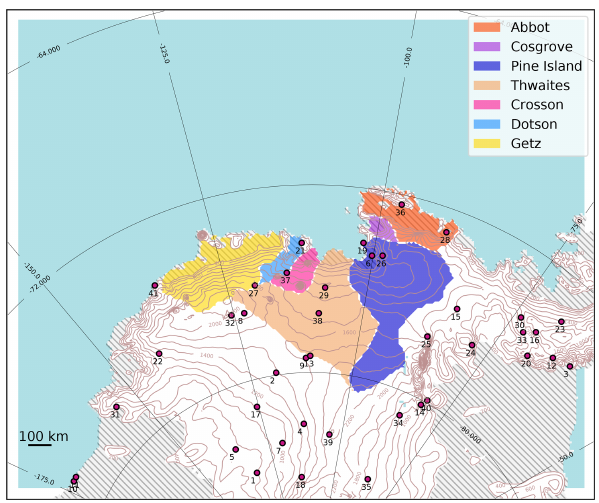
Figure 1. Simulation domain. The drainage basins (Rignot et al., 2019) under consideration in this paper are shaded in color and Au- tomatic Weather Stations (AWSs) are indicated with red points. The hatched area represents ice shelves and contour lines the surface el- evation (every 200m). Station names from 1 to 41: (1) Brianna, (2) Byrd, (3) Cape Adams, (4) Doug, (5) Elizabeth, (6) Evans Knoll, (7) Harry, (8) Janet , (9) Kominko-Slade, (10) Martha II, (11) Martha I, (12) Mount McKibben, (13) Noel, (14) Patriot Hills, (15) Siple Dome, (16) Ski Hi, (17) Swithinbank, (18) Theresa, (19) Backer Is- land, (20) Bean Peaks, (21) Bear Peninsula, (22) Clarke Mountains, (23) Gomez Nunatak, (24) Haag Nunatak, (25) Howard Nunatak, (26) Inman Nunatak, (27) Kohler Glacier, (28) Lepley Nunatak, (29) Lower Thwaites Glacier, (30) Lyon Nunatak, (31) Mount Pater- son, (32) Mount Sidley, (33) Mount Suggs, (34) Patriot Hills, (35) Steward Hills, (36) Thurston Island, (37) Toney Mountain, (38) Up Thwaites Glacier, (39) Whitmore Mountains, (40) Wilson Nunatak, (41) Russkaya. The relaxation zone is shown in white ( ∼